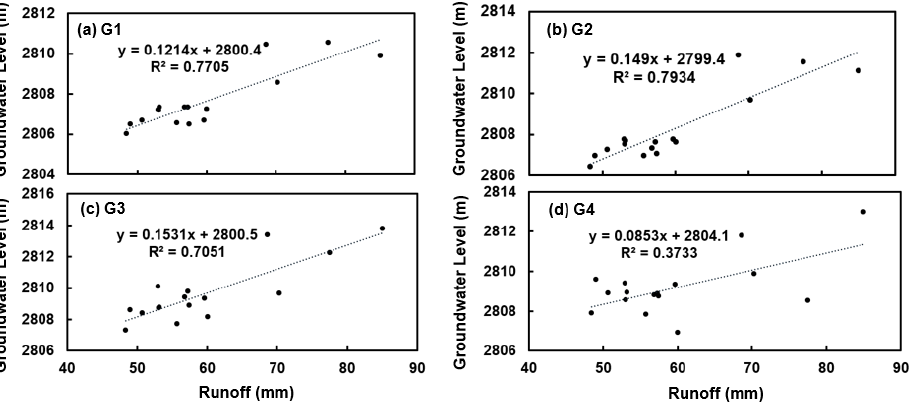
Figure 12. Correlation between the simulated annual runoff in the study catchment and observed groundwater level in G1 ( a ), G2 ( b ), G3 ( c )and G4 ( d ) (Figure 4b).